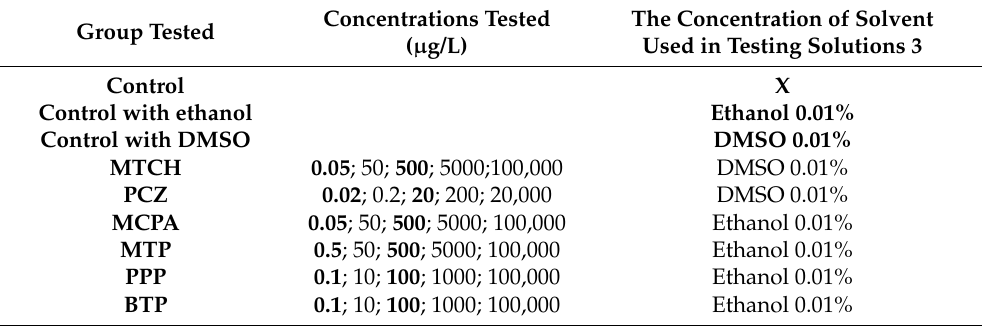
Table 1. Chemicals tested in the study, their concentrations, and an indication of the solvent used. Concentrations Tested The Concentration of Solvent Group Tested ( µ g/L) Used in Testing Solutions 3 Control X Control with ethanol Ethanol 0.01% DMSO